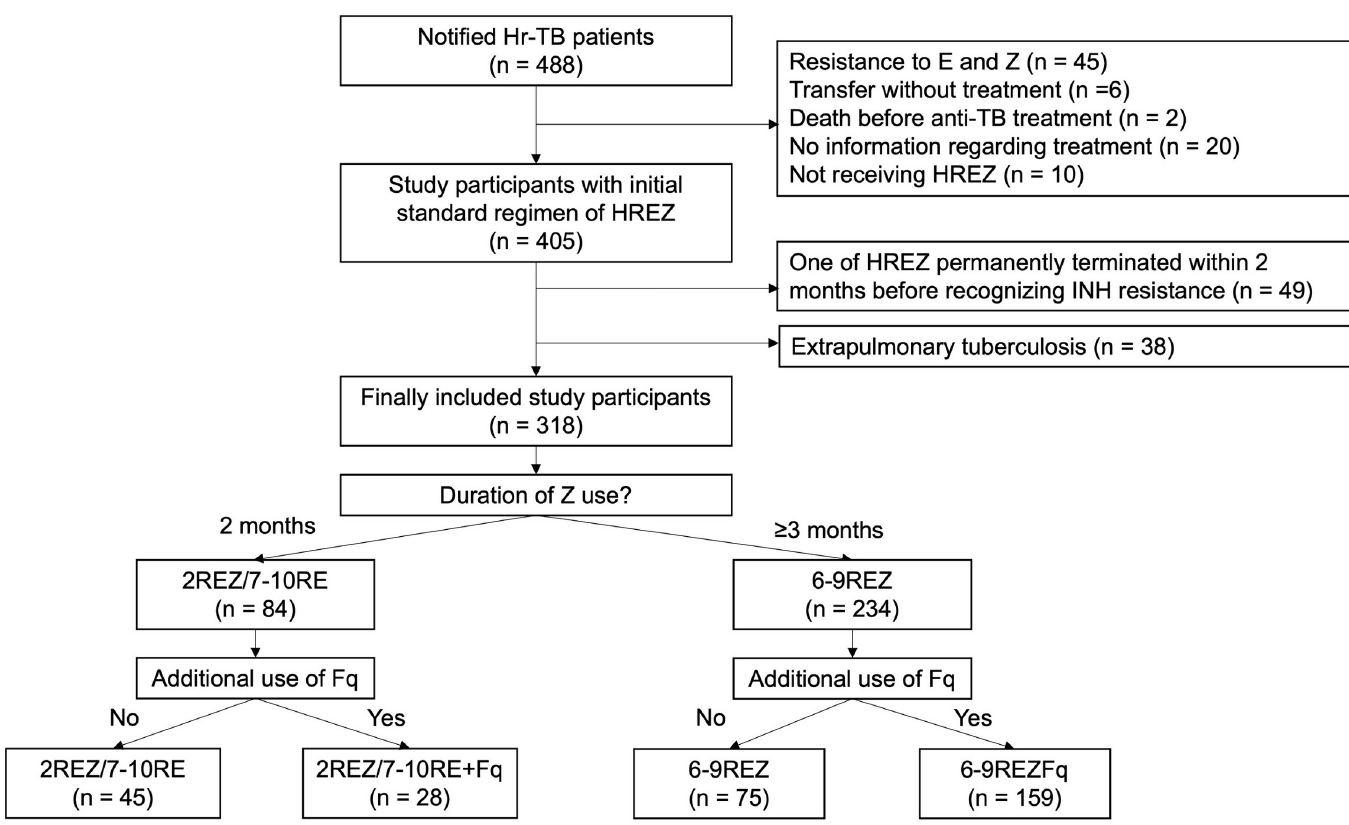
Fig 1. Flow chart of study participant enrollment. Hr, isoniazid-resistant; TB, tuberculosis; H, isoniazid; R, rifampicin; E, ethambutol; Z, pyrazinamide; Fq, fluoroquinolone.